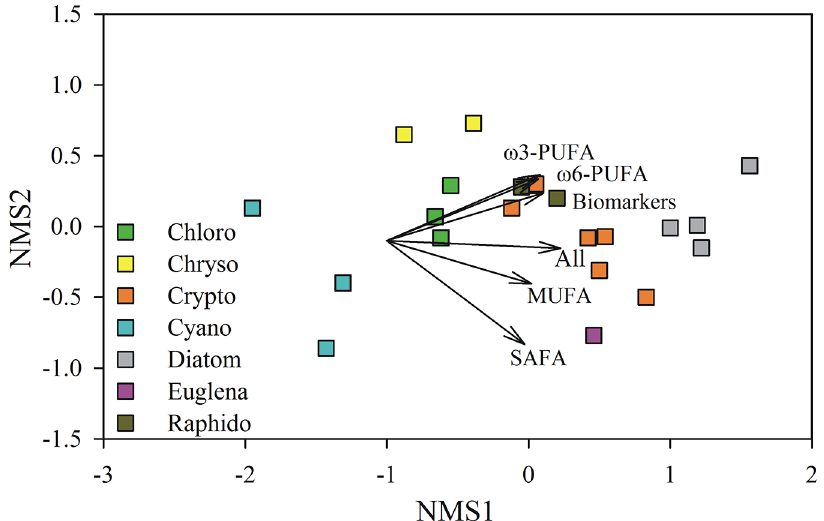
Fig 4. Isotopic distinction between freshwater phytoplankton by their δ 13 C value of fatty acids. A non- metric multidimensional scaling (NMS) plot visualizing the amongst-class differences in the phytoplankton isotopic difference ( Δ δ 13 C) between the bulk biomass and fatty acid groups. Stress for the 2-dimensional solution was 0.06, and the variables are presented as